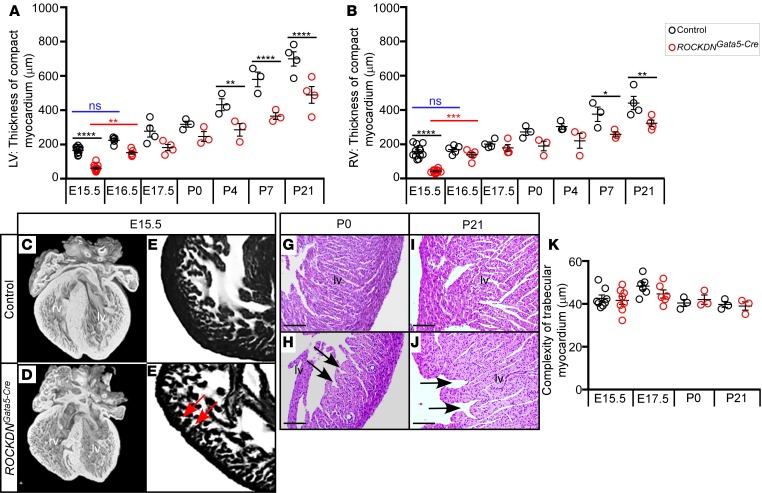
Impaired maturation of the ventricular wall in late fetal and postnatal ROCKDNGata5-Cre mutants.(A and B) Measurements of the compact myocardial wall were performed on transverse heart sections from E15.5 (n = 12), E16.5 (n = 5), and E17.5 (n = 4) embryos, and P0 (n = 3), P4 (n = 3), P7 (n = 3), and P21 (n = 4) postnatal pups, in both the left ventricle (A) and right ventricle (B), in control and ROCKDNGata5-Cre mutant littermates. During embryonic and postnatal development, generally, the compact myocardium of the control hearts is thicker than in mutant hearts. In particular, in the left ventricle, the control compact myocardium is significantly thicker than in the ROCKDNGata5-Cre mutant compact myocardium at E15.5, P4, P7, and P21 (A); and in the right ventricle it is significantly thicker at E15.5, P7 and P21 (B). From E15.5 to E16.5 in ROCKDNGata5-Cre mutant hearts, myocardial wall thickness increased significantly, in both the left ventricle and right ventricle (red lines), whereas no corresponding significant increase was observed in control hearts (blue lines). (C–F) High-resolution episcopic microscopy imaging at E15.5 showed that ROCKDNGata5-Cre hearts (D and F) displayed an immature thin myocardial wall containing myocardial crypts within the compact myocardium (red arrows F) compared with controls (C and E). n = 10 for each genotype. (G–J) Phenotypic analysis of 4-chamber view sections from postnatal hearts, stained with the histological stain H&E, confirmed that in the ROCKDNGata5-Cre hearts the ventricular wall was visibly thinner and that it also contained myocardial crypts (arrows) at P0 and P21. n = 3 for each genotype at each time point. (K) Trabecular complexity for each heart was assessed by calculating the ratio of trabecular myocardial area to compact myocardium area throughout the ventricles. There were no significant differences between control and mutant hearts during fetal and postnatal development, confirming that ROCKDNGata5-Cre mutants did not have a non-compaction phenotype. E15.5 (n = 8), E17.5 (n = 6), P0, and P21 (n = 3) for each genotype at each time point. Data are presented as mean ± SEM. *P < 0.05, **P < 0.01, ***P < 0.001, ****P < 0.0001 by 1-way ANOVA with Bonferroni’s correction for multiple comparisons. lv/LV, left ventricle; rv/RV, right ventricle. Scale bars: 100 μm.